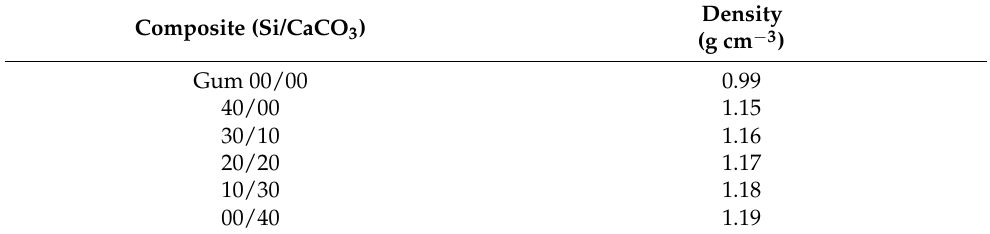
Table 2. Densities of the composites.